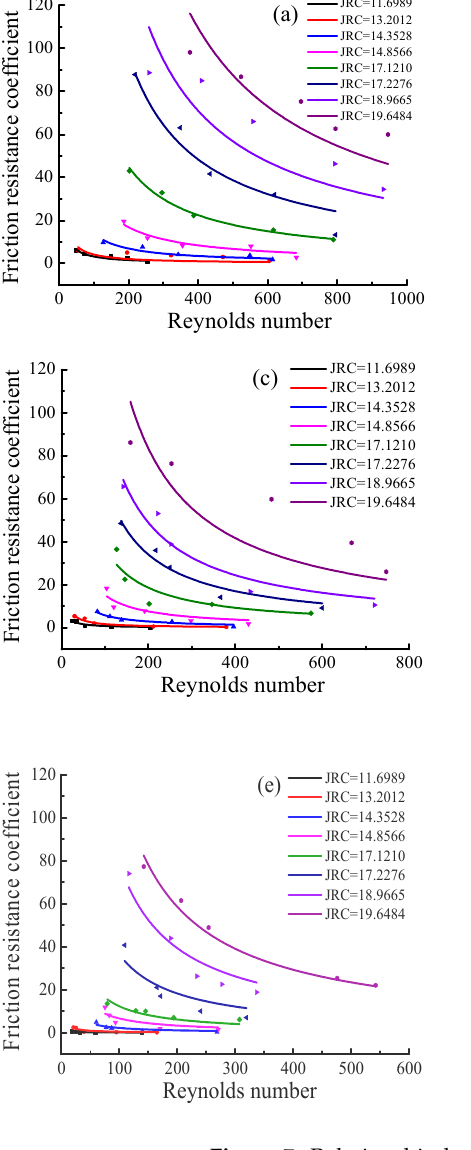
Figure 7. Relationship between the Reynolds number and the frictional resistance coefficient under different normal stresses and different JRC values. ( a ) Normal stress = 0.10 MPa, ( b ) Normal stress = 0.15 MPa, ( c ) Normal stress = 0.20 MPa, ( d ) Normal stress = 0.25 MPa, ( e ) Normal stress = 0.30 MPa, ( f ) Normal stress = 0.40 MPa.